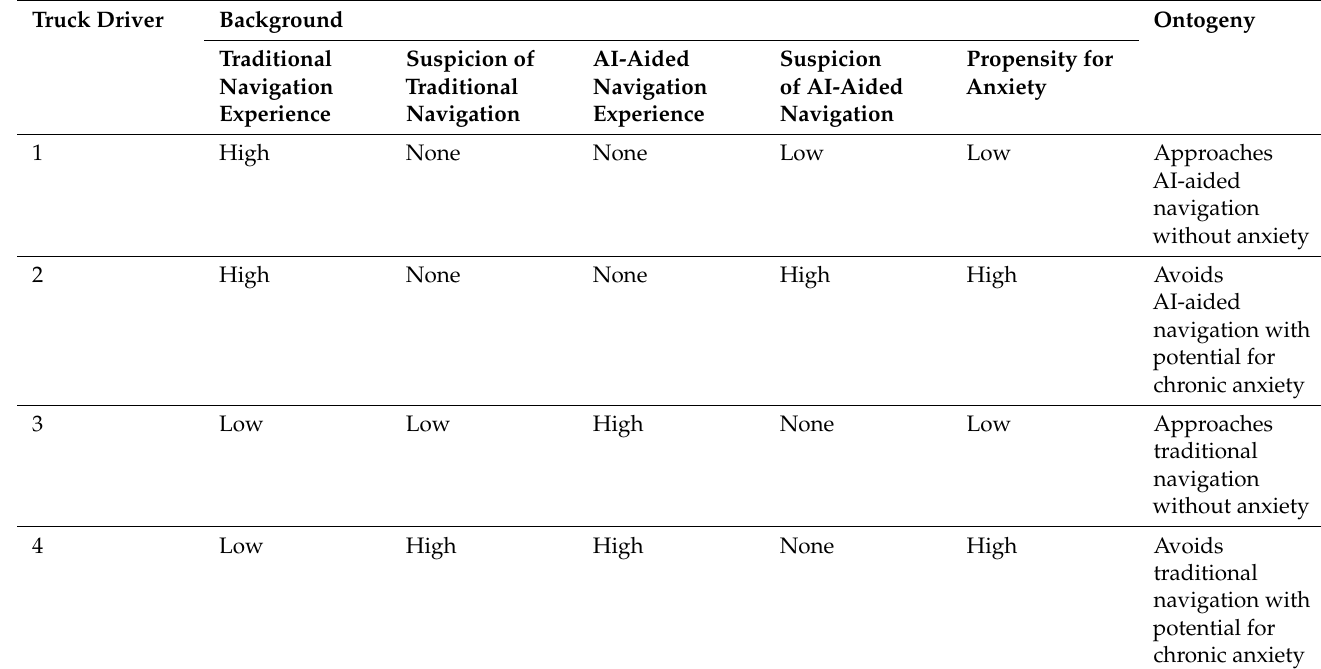
Table 4. Ontogeny: Effects of background on stress when interacting with